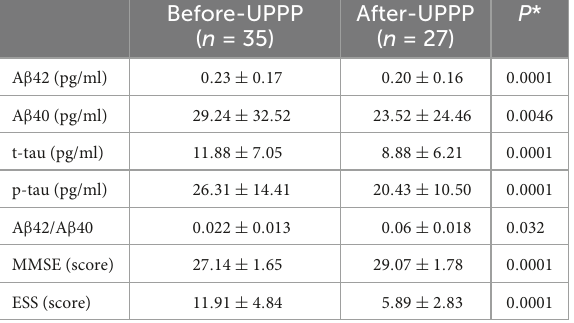
TABLE 2 Differences of Mini Mental State Examination Scale (MMSE), Epworth Sleepiness Scale (ESS), and Alzheimer’s disease (AD) biomarkers before and after surgery for case group.